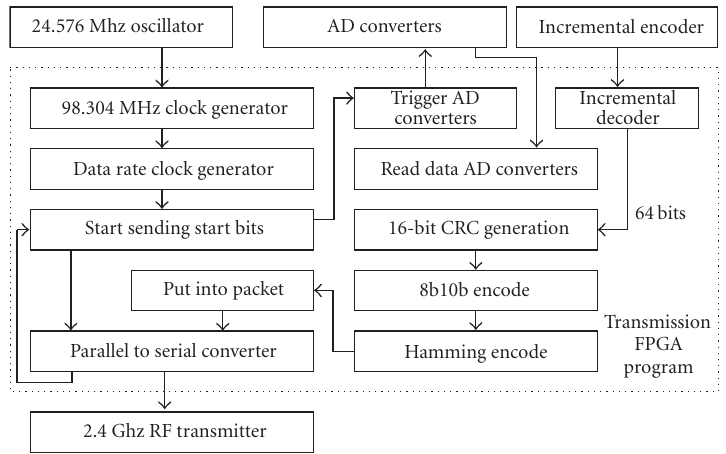
Figure 4: Schematic of FPGA transmitter protocol.